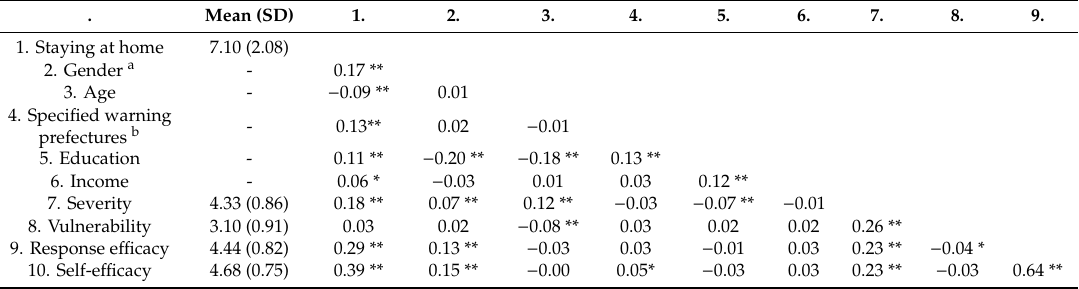
Table 2. Correlations between variables (n =